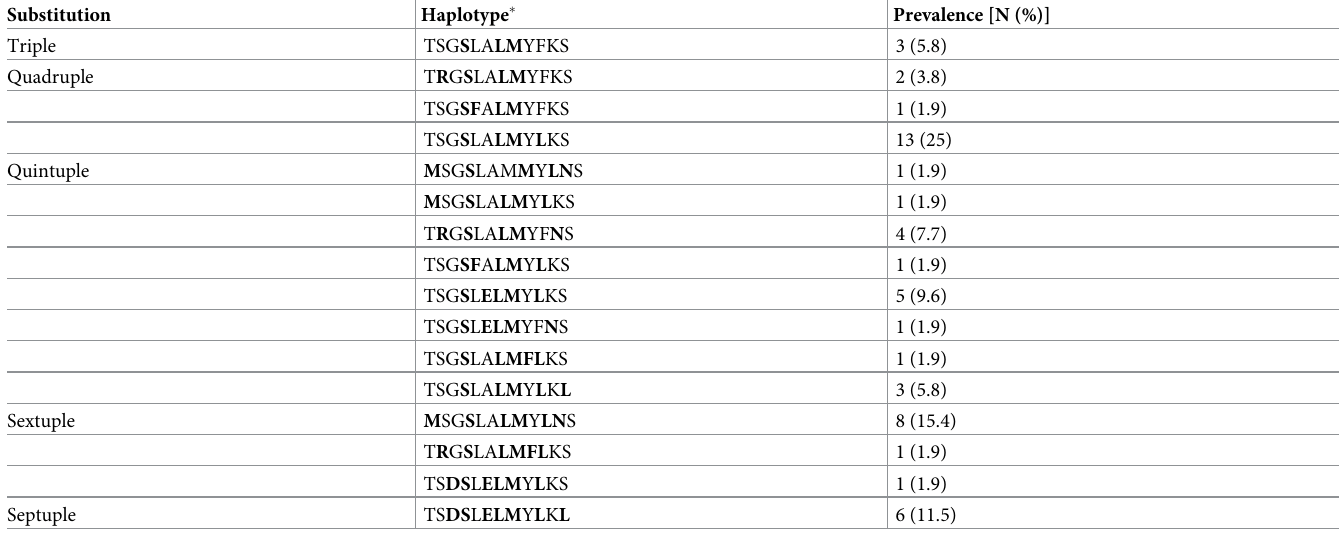
Table 3. Prevalence of Pvmdr1 haplotypes in clinical P . vivax